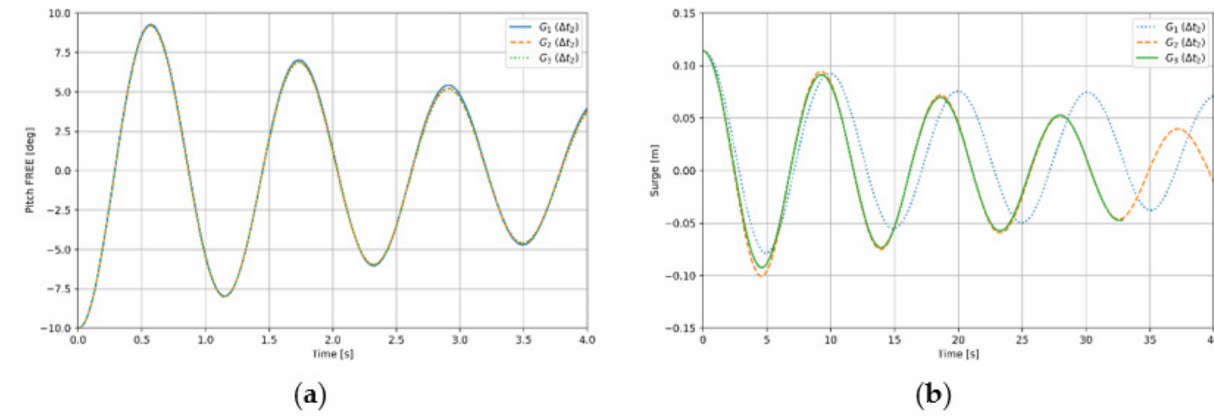
Figure 9. Time histories of freely decaying pitch: ( a ) heave; ( b ) motions obtained on grids G 1 , G 2 , and G